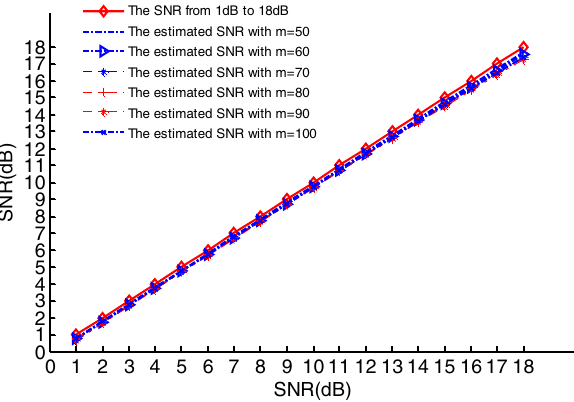
Figure 7. The estimated SNR using the different covariance matrix with different dimensions.